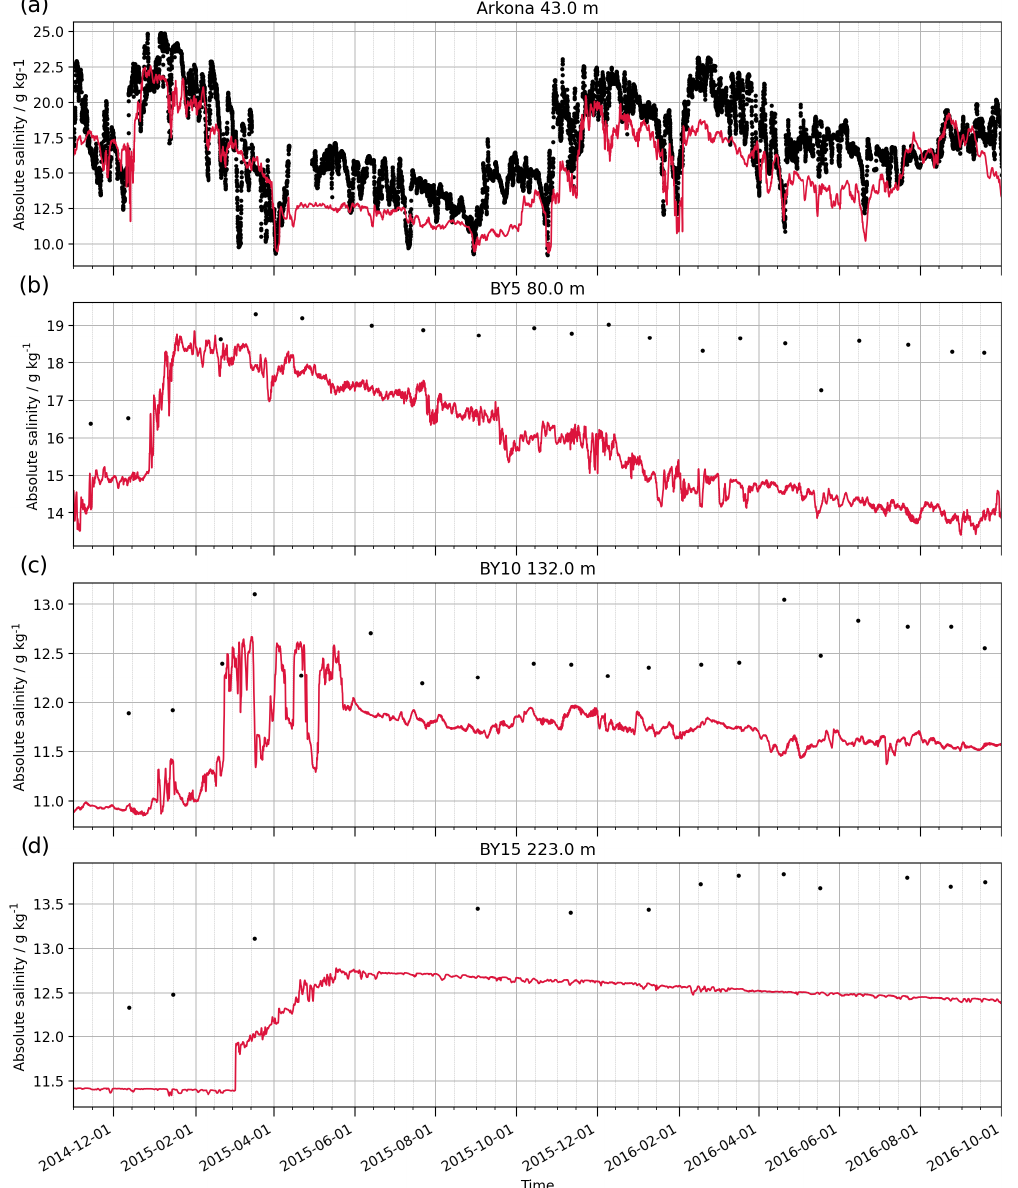
Figure 10. Time series of bottom salinity at selected locations. The red line denotes the model, and the black dots are the